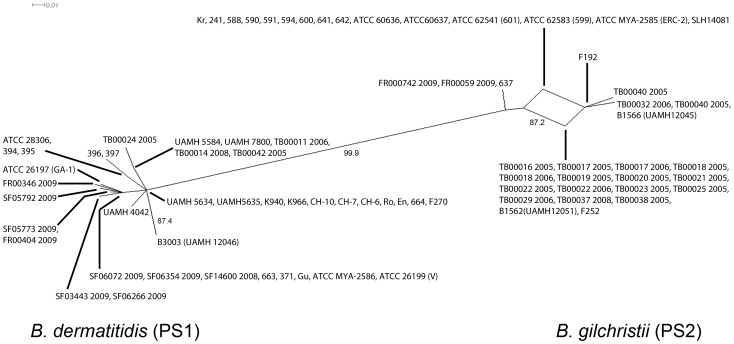
Phylogenetic network analysis
of the
B. dermatitidis. Split decomposition analysis was performed using the pairwise genetic distances of the concatenated chs2-drk1-fads-pyrF-tub1-arf6-its2 sequences. Isolated split networks within B. gilchristii (PS2) suggests recombination within the B. gilchristii (PS2) but not between both populations. Bootstrapping values less than ≤0.75 are not shown.